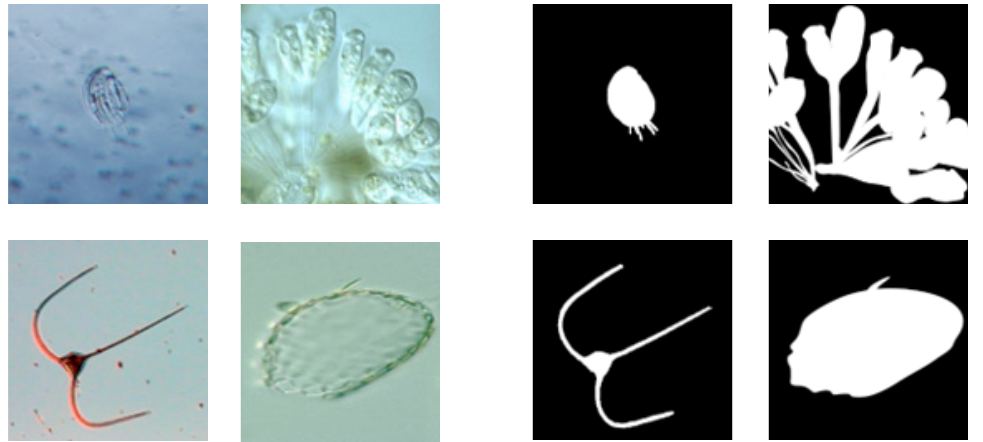
Figure 1. Different types of EMs. They have various shapes and sizes and often have vague edges because of their transparency and the lens being out of focus.